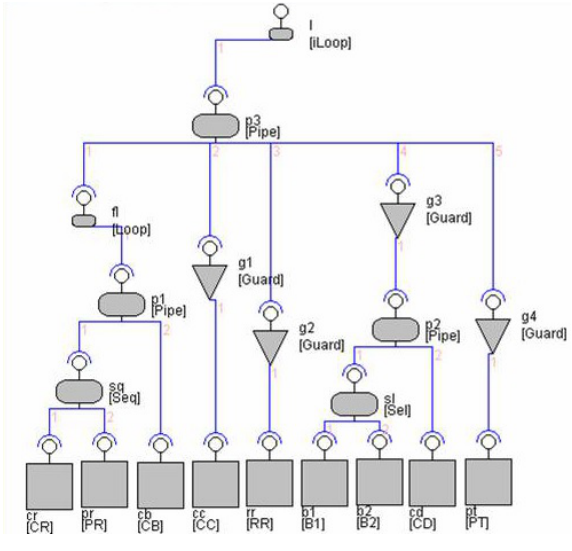
Figure 26. The ATM